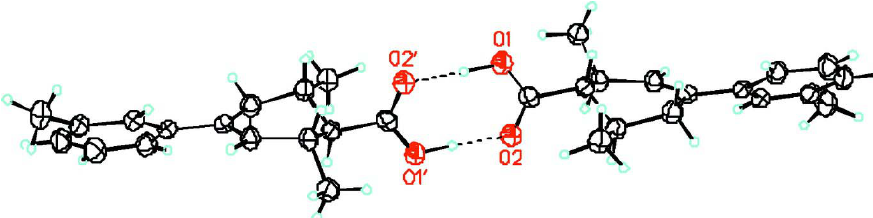
The molecular structure and atom numbering scheme.